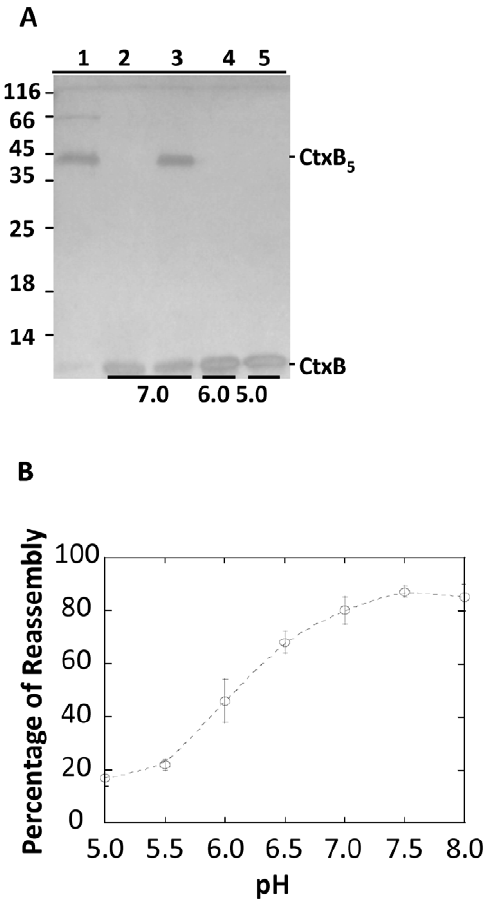
Figure 1. Reassembly of CtxB as function of pH. A. Reassembly of CtxB into SDS stable pentamer. Equal amount of reassembled CtxB was applied on each lane of a SDS-PAGE. CtxB reassembled for 0 min and 30 min at pH 7.0 (lanes 2 and 3), or for 30 min at pH 6.0 (lane 4) or and at pH 5.0 (lane 5). Lane 1 is the native CtxB 5 . Molecular weight standards are indicated in kDa on the left of the gel. The respective apparent positions of the native CtxB pentamer and of the CtxB monomer are indicated on the right of the gel. B. Reassembly of CtxB into species capable of recognizing GM1. CtxB 5 ( # ) was treated at pH 1.0 for 15 min and subsequently diluted to a final concentration of 8.6 m M in McIlVaine buffers at indicated pH. The samples were incubated for 30 min at 23 u C and analyzed by GM1-Elisa. The results of three independent experiments are shown as a mean 6